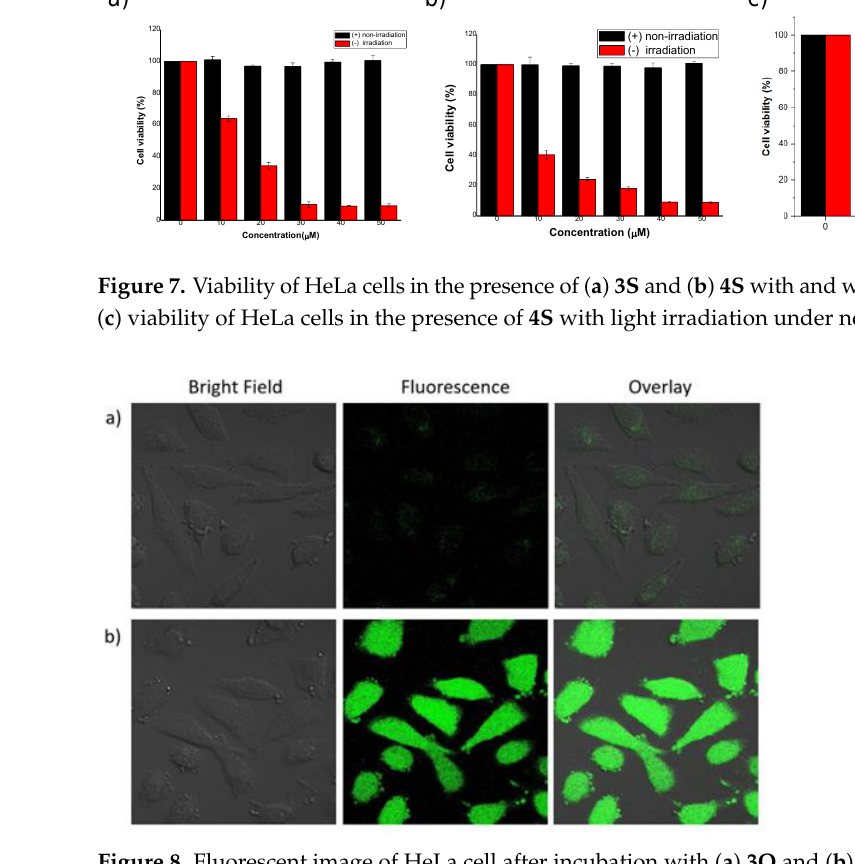
Figure 8. Fluorescent image of HeLa cell after incubation with ( a ) 3O and ( b ) 4O . Fluorescent image of HeLa cells in the presence of DCFH-DA and 4S ( a ) before and ( b ) after irradiation.